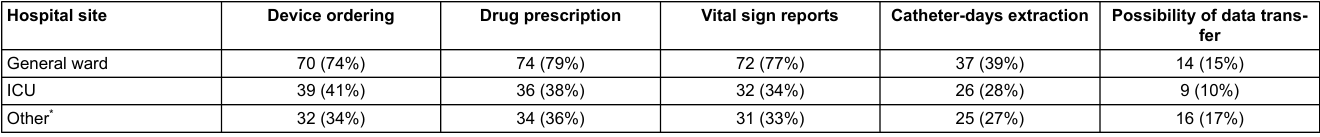
Table S2: EMR capacities by hospital site.